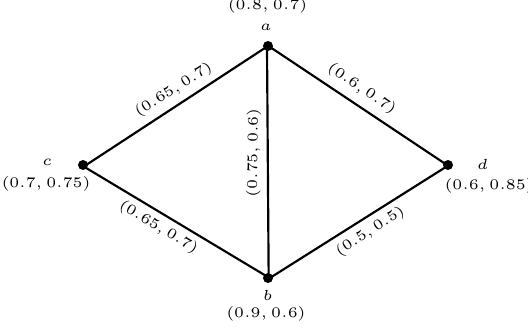
Figure 5. A 3-rung orthopair fuzzy graph G . Figure 3.3: A 3-rung orthopair fuzzy graph G such that each pair of vertices is joined by an edge in G . 178